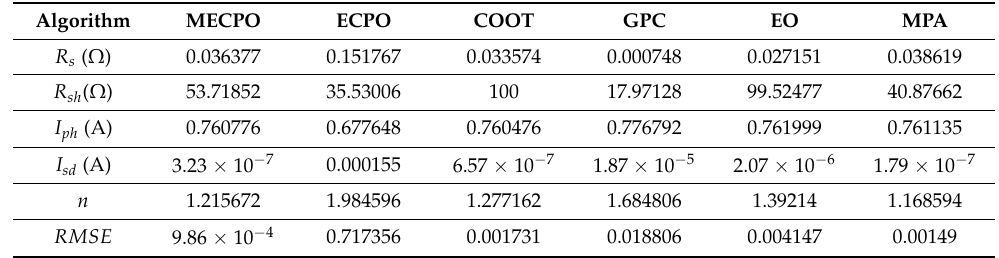
Table 6. Calculated parameter in case of the SDM obtained by the proposed algorithm and other recent